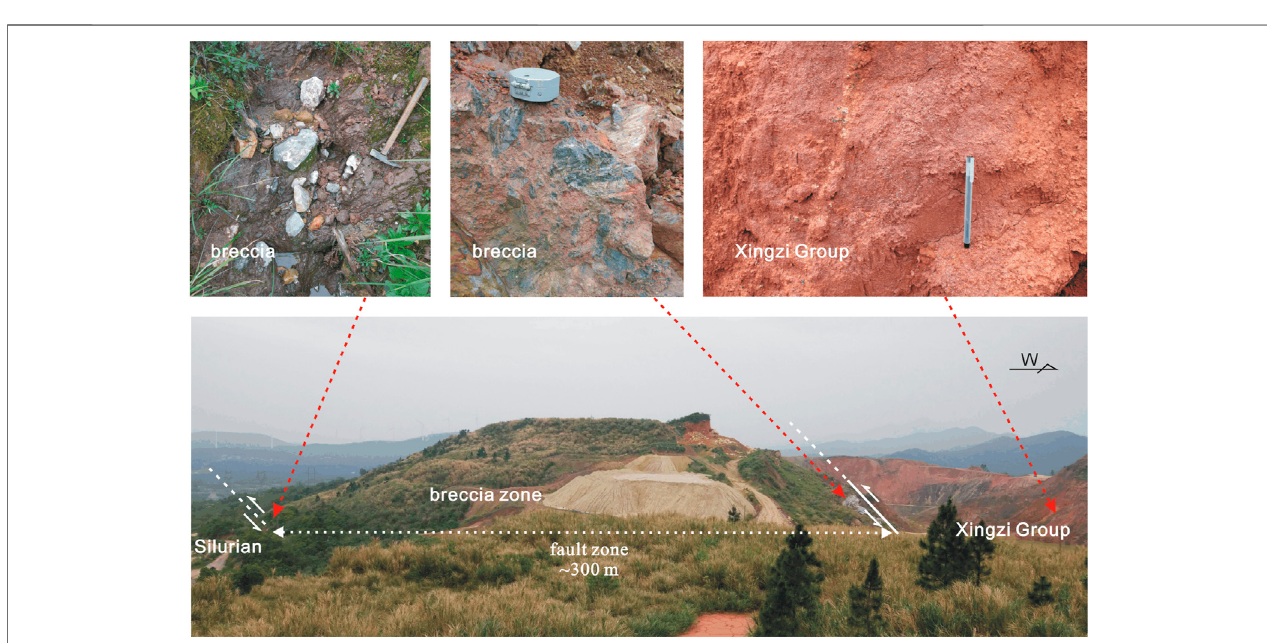
Frontiers in Earth Science |